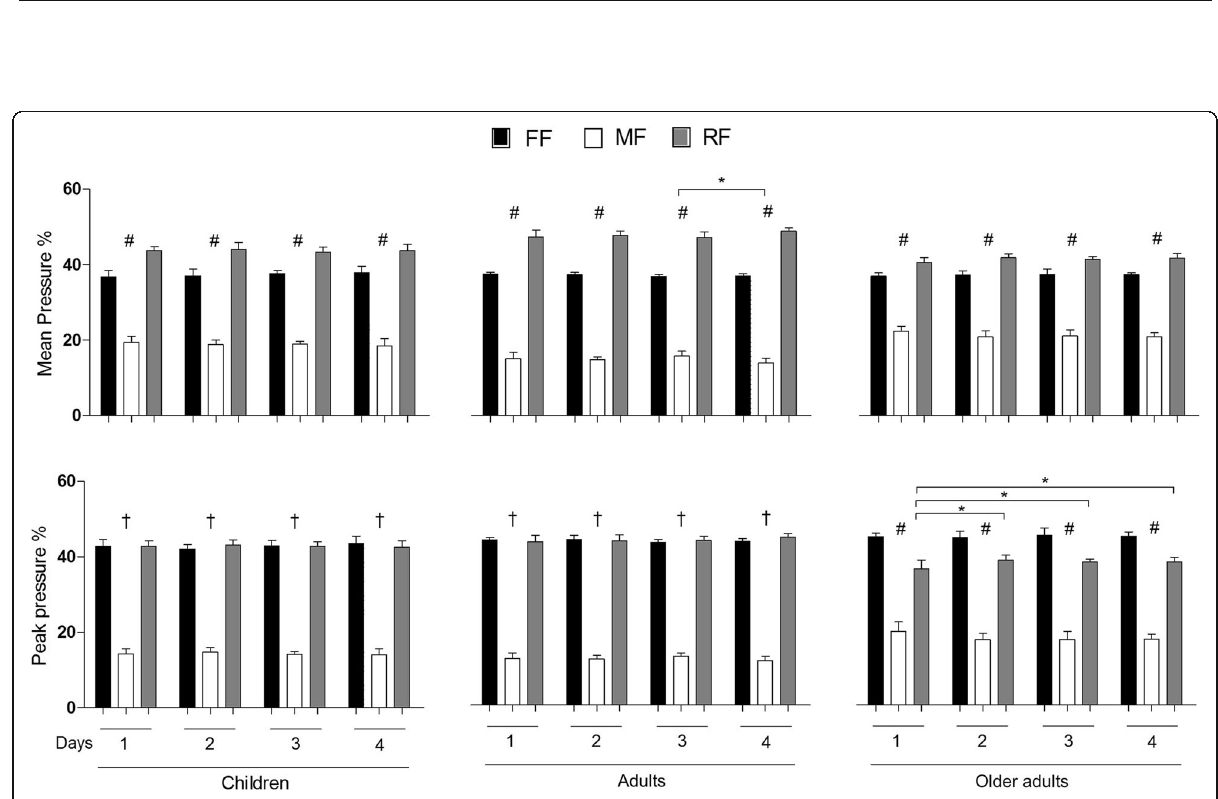
Fig. 3 Peak pressure determined in different foot regions and expressed as a percentage of total foot pressure. Data are presented for each step and group in the four days of measurement. * indicates difference between the steps